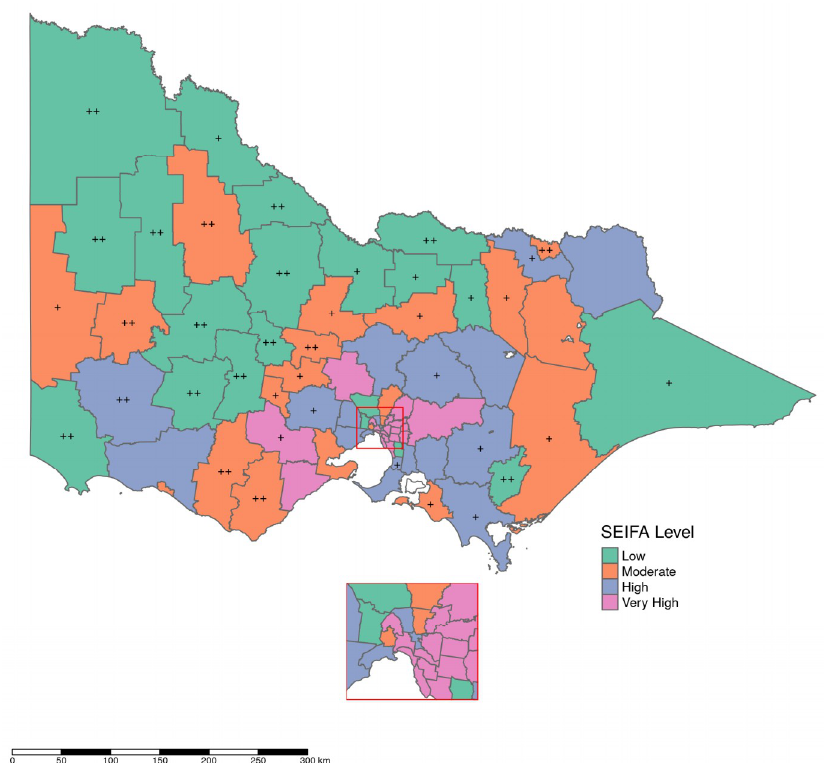
Figure 3. Dispensing of opioids in 2015 in local government areas (LGAs) of four types of neighborhood. LGAs with very high dispensing were marked with ++; high dispensing were marked with +; and, normal dispensing were marked with no sign.